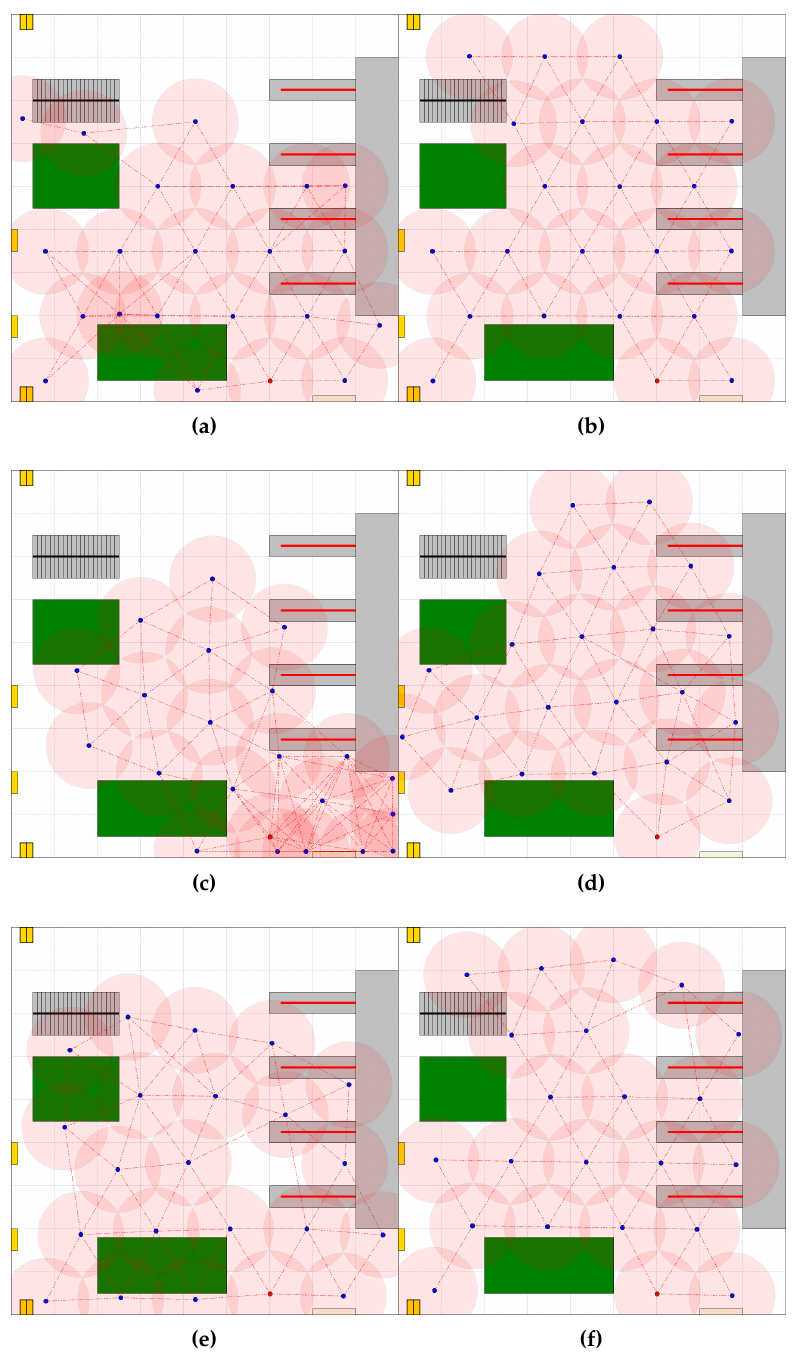
Figure 6. Created network topologies, various deployment strategies: ( a , b ) pre-defined (Variants A and B); ( c ) self-organizing (Variant A); ( d ) hybrid deployment (Hybrid 1, Variant B); ( e , f ) hybrid deployment (Hybrid 2, Variants A and